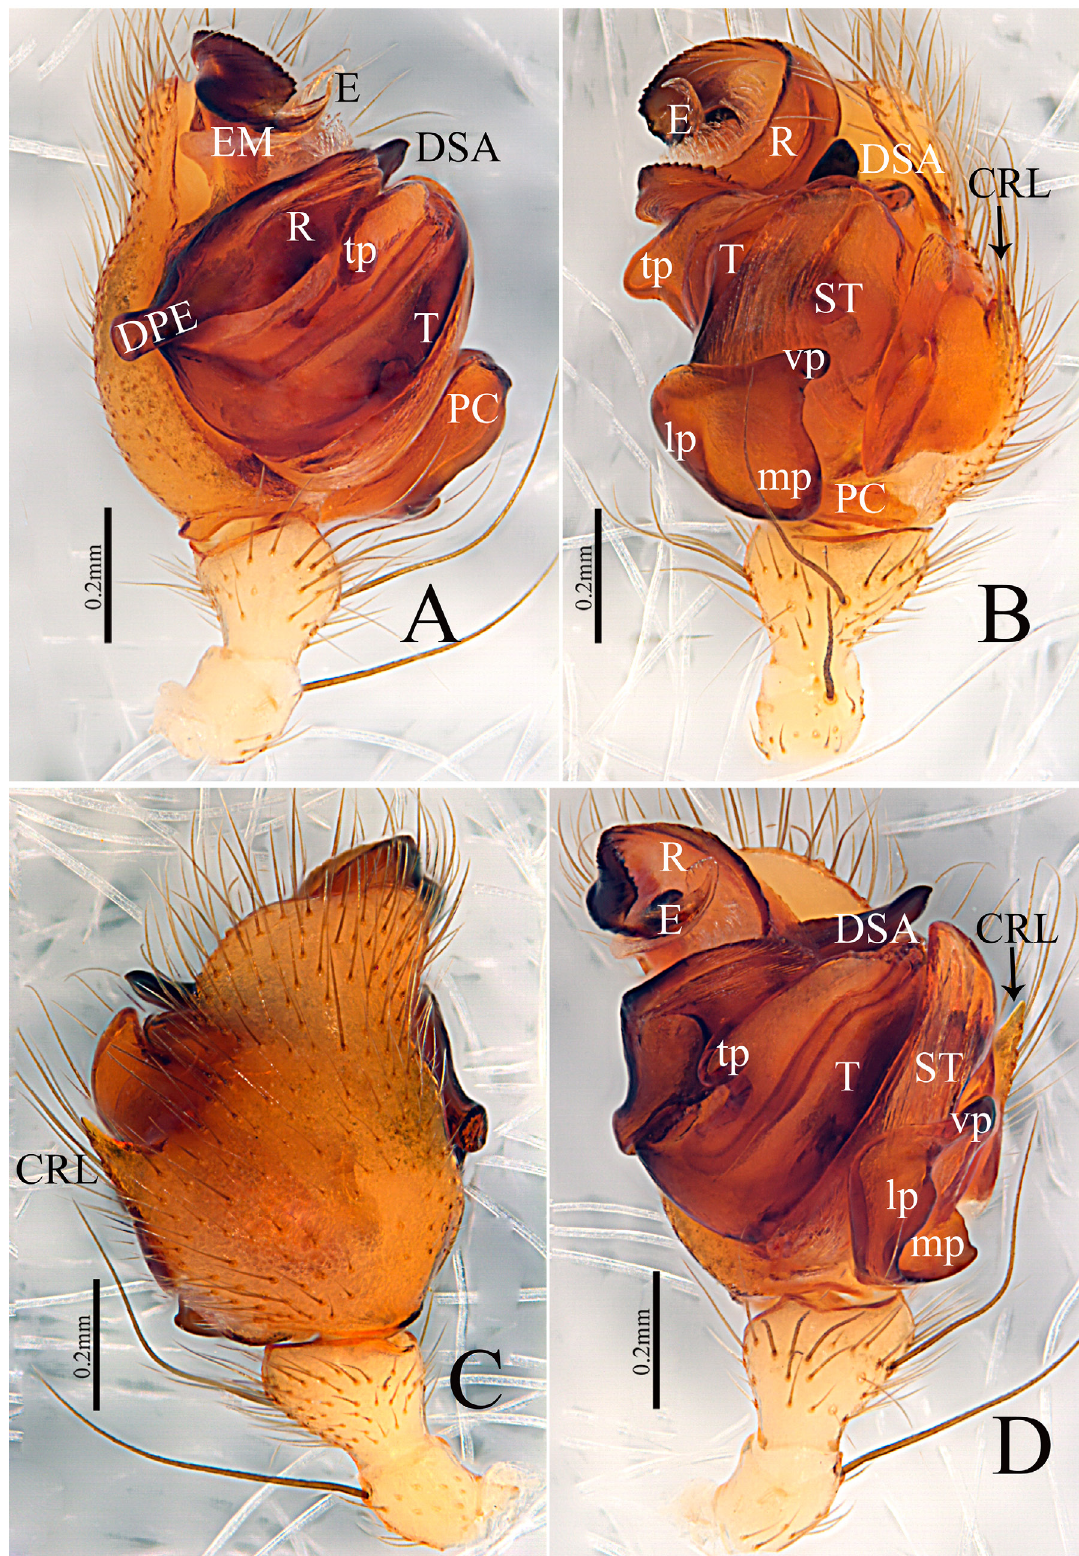
Fig. 1. Acroterius absentus gen. et sp. nov., ♂, holotype (HNU-Tang031027), palp. A . Prolateral view. B . Retrolateral view. C . Dorsal view. D . Ventral